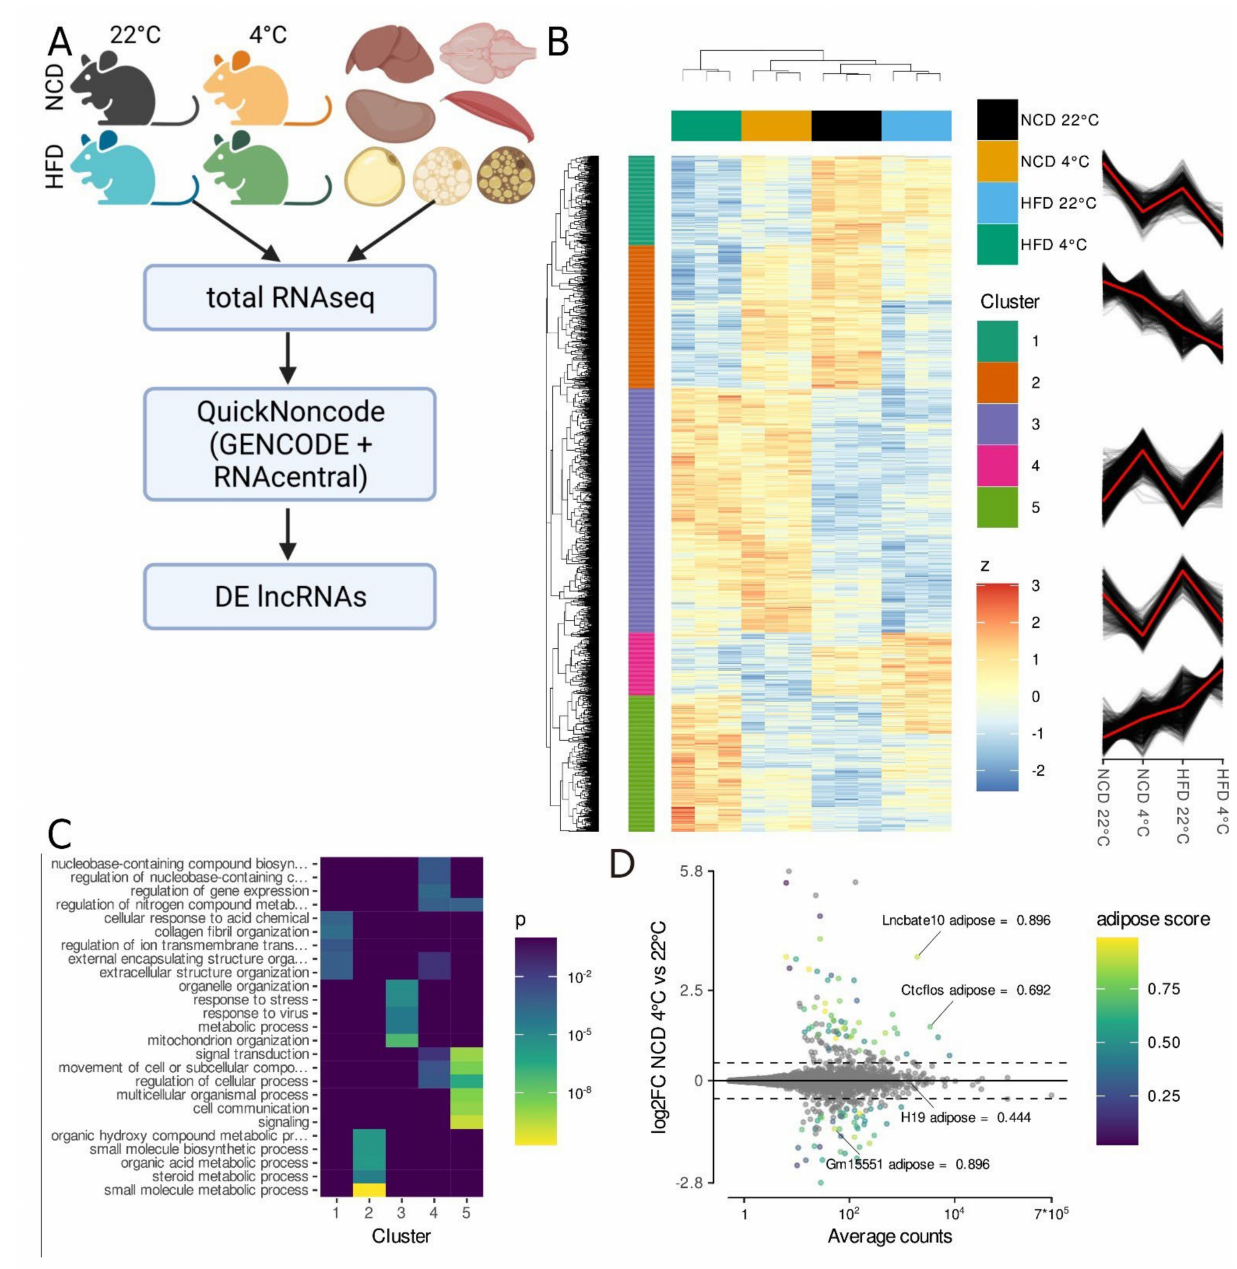
Figure 1. RNA-Seq reveals temperature and obesity dependent changes in iBAT lncRNA expression. ( A ) Experimental design. Total transcriptomes from the interscapular brown adipose tissue (iBAT) of 20-week-old mice housed at 22 ◦ C or 4 ◦ C for 24 h ( n = 3) fed either a high-fat (HFD) or a control diet (NCD) for 12 weeks were analysed together with the total-transcriptomes from seven metabolically active tissues ( n = 1, GSE121345). The union of GENCODE and RNAcentral annotated genes was used for the analysis to reveal which are both adipose tissue specific and regulated by physiologically relevant stimuli. Created with BioRender.com (the last access on 10 April 2022). ( B ) Hierarchical clustering of genes differentially regulated by diet and cold treatment in adipose tissue (likelihood ratio test (LRT), FDR < 0.001). Colour code depicts row-wise standardised expression. ( C ) Gene ontology (GO) enrichment analysis for the gene clusters shown in ( B ). ( D ) Expression levels and changes for long noncoding RNA (lncRNA) genes in iBAT from cold treated compared to control mice on control diet. Genes showing significant differential gene expression are colour-coded, indicating their adipose tissue specificity (Wald test, log2FC > 0.5, n = 6, s <